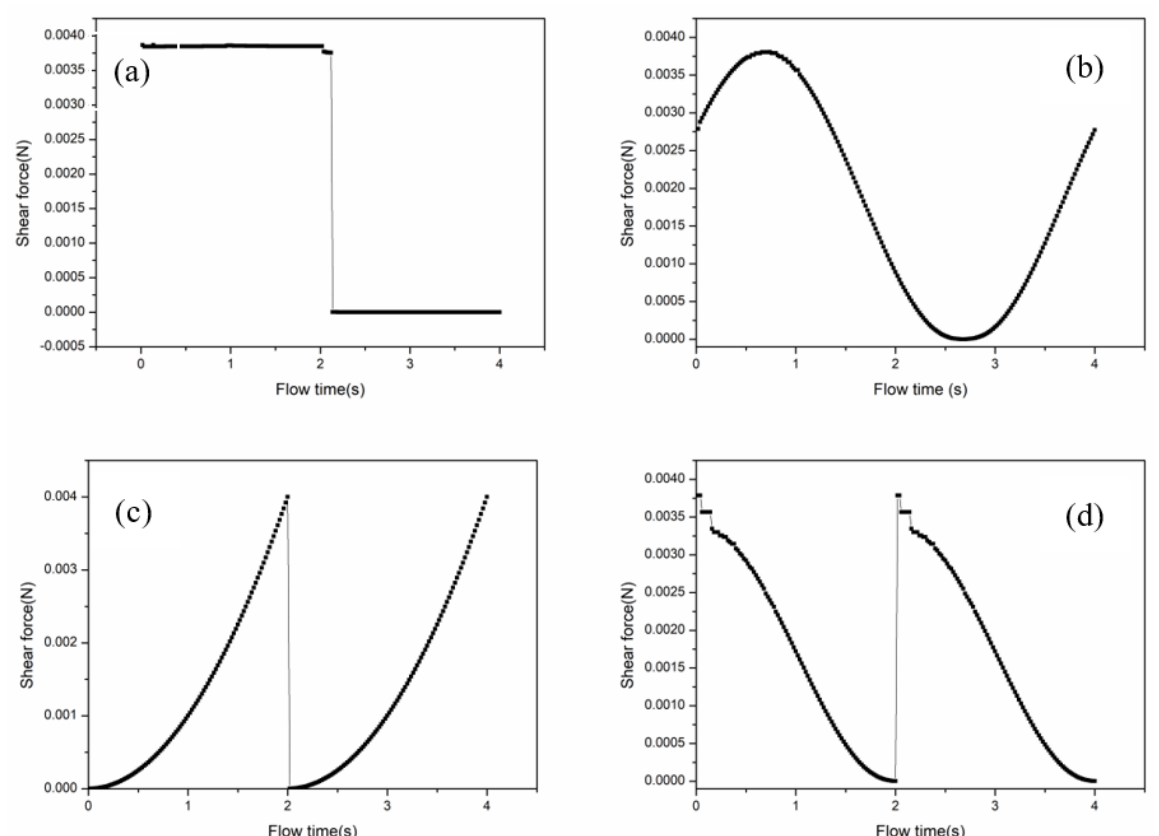
Figure 3. Shear profiles at the inlet of the membrane module for the four functional feed modes,( a ) square wave, ( b ) sine, ( c ) reciprocal, and ( d ) power functional. ( a ) square wave, ( b ) sine, ( c ) reciprocal, and ( d ) power